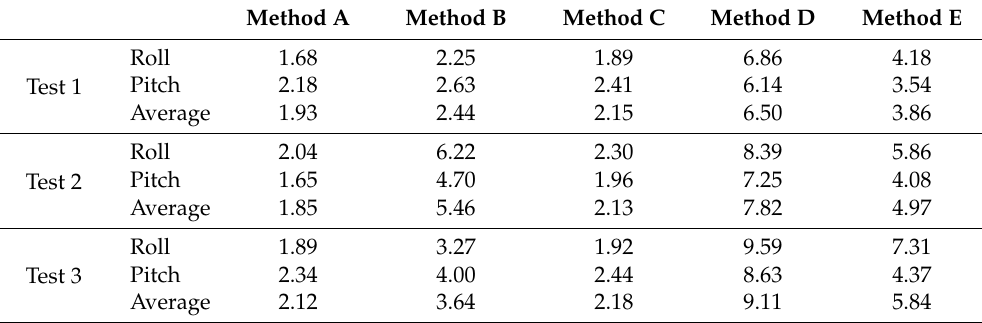
Table 1. Root mean square errors of attitude (unit: ◦